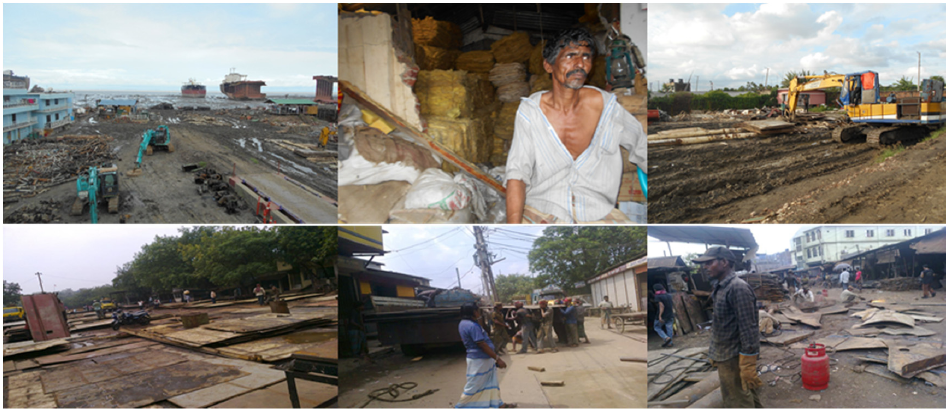
Figure 1. Shipbreaking yard with grab ( top left ), glasswool shop in Bhatiraty ( top middle ), magnetic grab carrying small sections for loading ( top right ). Shipbreaking scrap business in Dhaka city ( bottom left ), workers carrying plate in shoulder in Dhaka city ( bottom middle ), Cutters working in Dhaka city ( bottom right ). Photo Credit: First author, 14 June 2014.